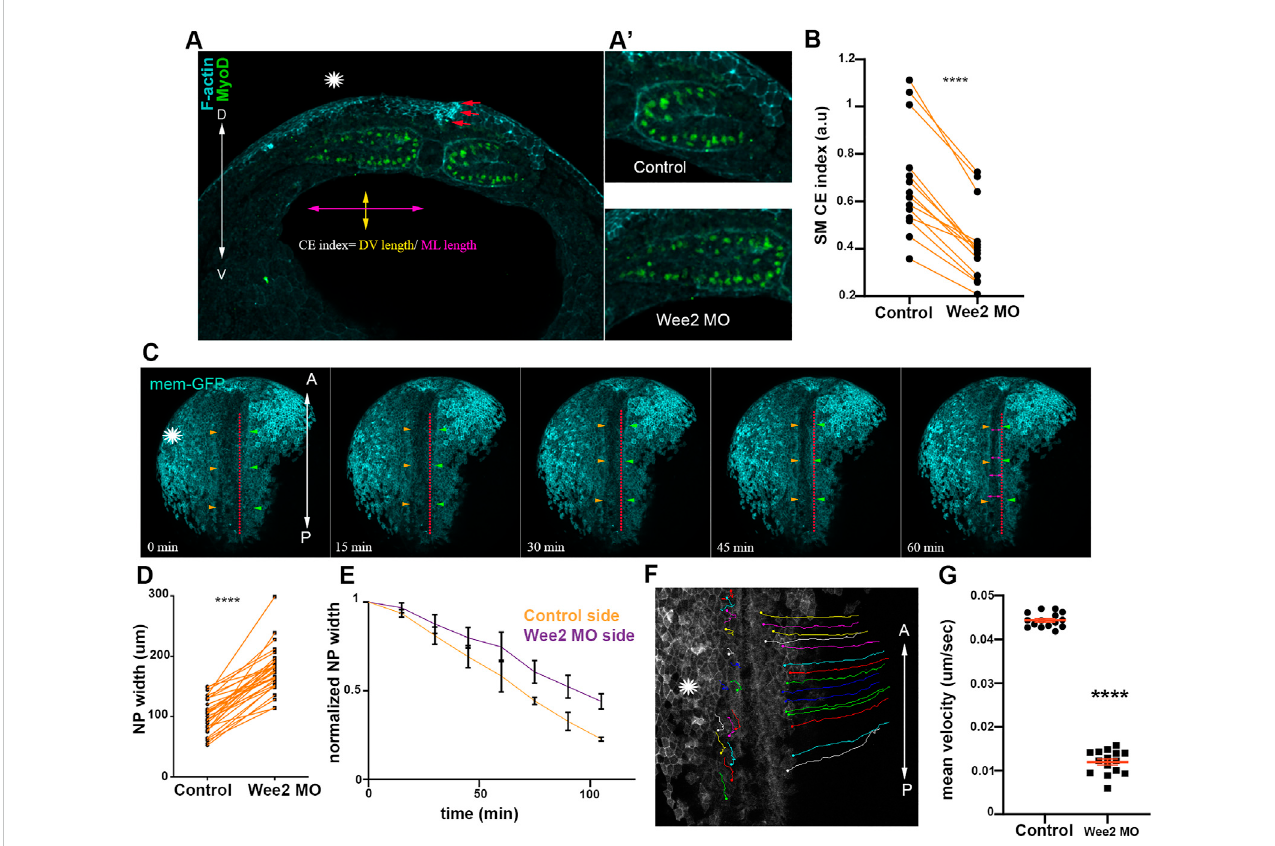
FIGURE 3 Somitic mesoderm convergent extension in necessary for neural tube closure. (A) Transverse cross section a representative Wee2 morphant stage 16 embryo. Yellow double arrowhead: somite dorsoventral (D/V) length. Purple double arrowhead: mediolateral (M/L) somite length. Asterisk indicated the Wee2morphantside.Redarrows:hingepointattheneuralplatesideoverlyingnormalsomiticmesoderm. (D) dorsal.V,ventral. (A ’ ) Zoomedimagesofcontrol and Wee2 morphant somitic mesoderm. Scale bar:100 μ m (B) Quanti fi cation of somitic mesoderm convergent extension index in control Wee2 morphant somitic mesoderm. Two-sided paired Student ’ s t -test;**** p < .0001; n = 14 embryos. (C) Stills showing the dorsal side of theembryo from a time lapse recording of a neurula embryo with unilateral Wee2 morphant somitic mesoderm. Asterisk: Wee2 morphant side. Red dotted line: neural plate midline. Green arrowheads: Neural plate boundary at the side overlying control somitic mesoderm. Orange arrowheads: Neural plate boundary at the side overlyingWee2morphantsomiticmesoderm.NTCisdelayedattheneuralplatesideoverlyingWee2morphantsomiticmesoderm(purplearrowheads).Scale bar: 100 μ m (D) Quanti fi cation of neural plate mediolateral width extension. Neural plate is wider when the underlying somitic mesoderm is targeted with Wee2 morpholino. Two-sided paired Student ’ s t -test; **** p < .0001; n = 32 embryos. (E) Quanti fi cation of neural plate width over time. 3 regions along the anteroposterior axis of a neurula embryo were followed over time. Neural plate width at the side overlying Wee2 morphant somitic mesoderm remains wider asneurulationprogresses. (F) Dorsalviewfromatrackedtimelapserecordingfor1 htimeperiod,showingsurfaceectodermboundarycellsmovementduring neural tube closure. Asterisk: Wee2 morphant somitic mesoderm side. (A) Anterior; P: Posterior. Scale bar: 100 μ m (G) Quanti fi cation of surface ectoderm boundary cells velocity as a proxy for neural plate hinge point movement. The velocity of surface ectoderm boundary cells is signi fi cantly reduced